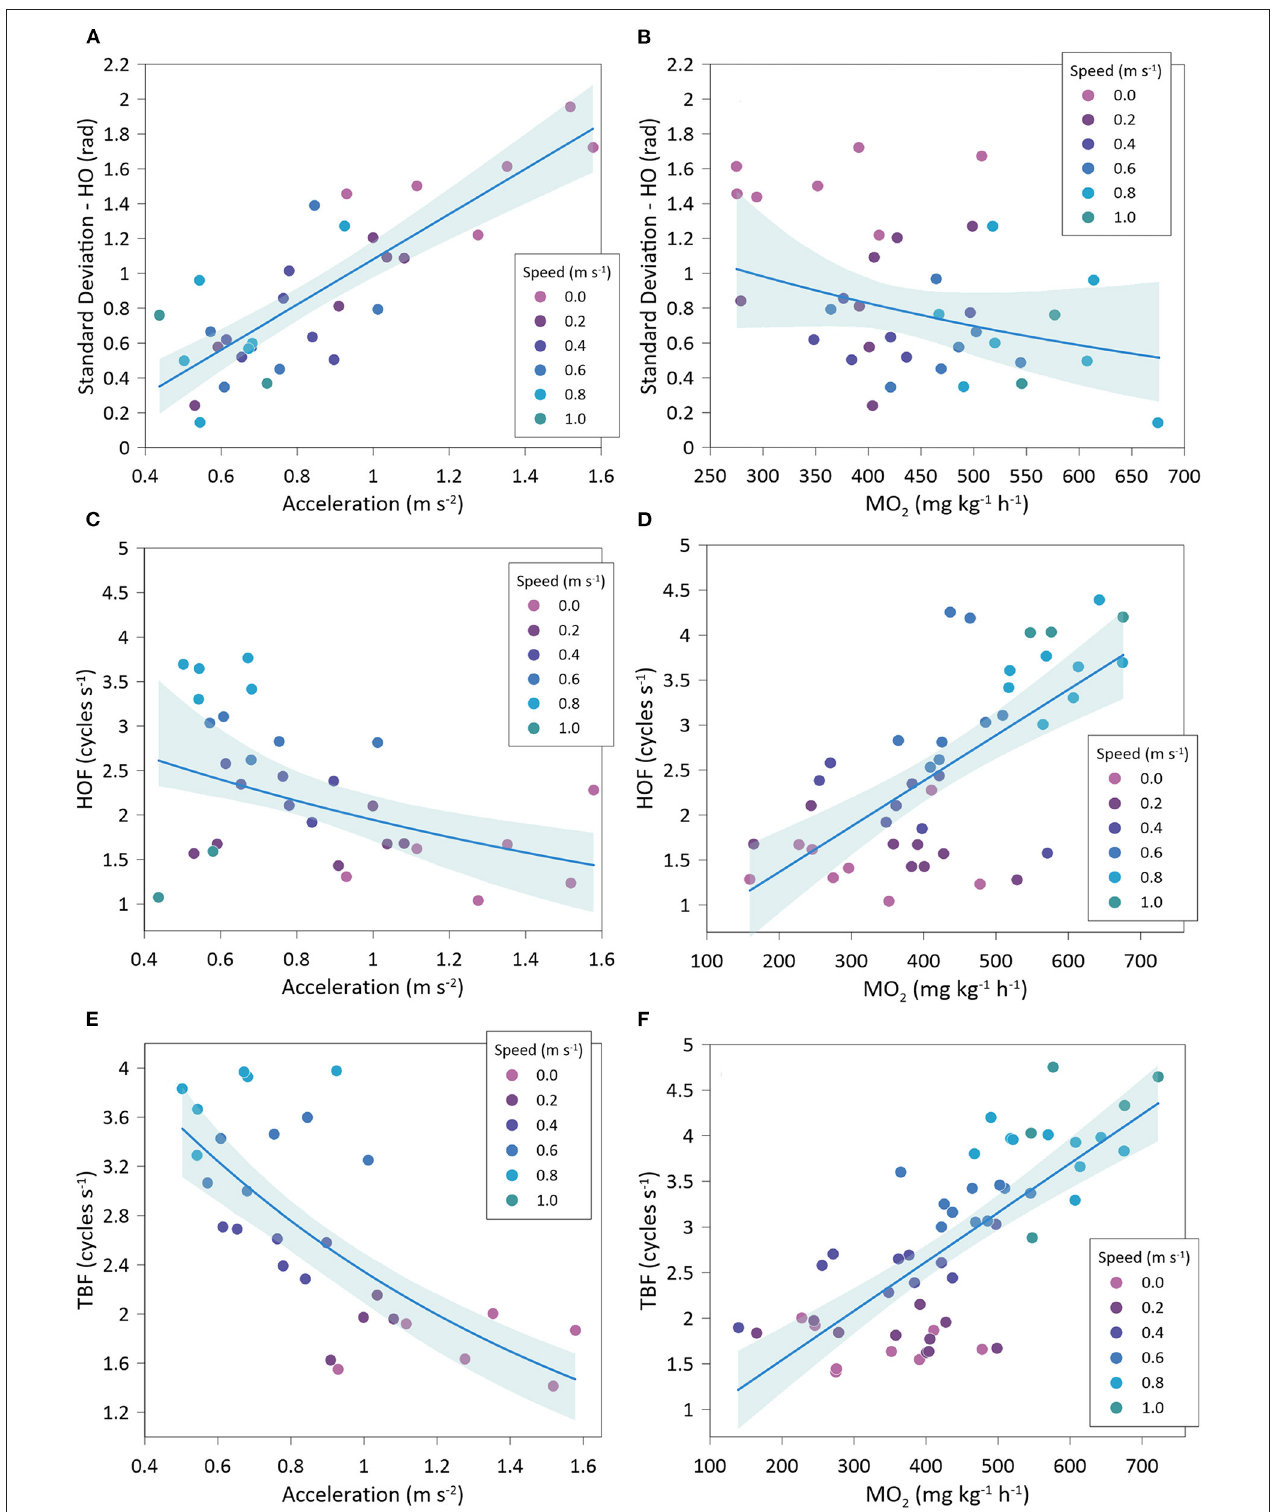
FIGURE 8 | Best-fitted regression of Sparus aurata accelerations and oxygen consumption (MO 2 ) with body motion parameters at different swimming speeds. (A) variations of head orientation (SD-HO) and accelerations; (B) variations of head orientation (SD-HO) and oxygen consumption; (C) head orientation frequency (HOF) and accelerations; (D) head orientation frequency (HOF) and oxygen consumption; (E) tail beat frequency (TBF) and accelerations; (F) tail beat frequency (TBF) and oxygen consumption.